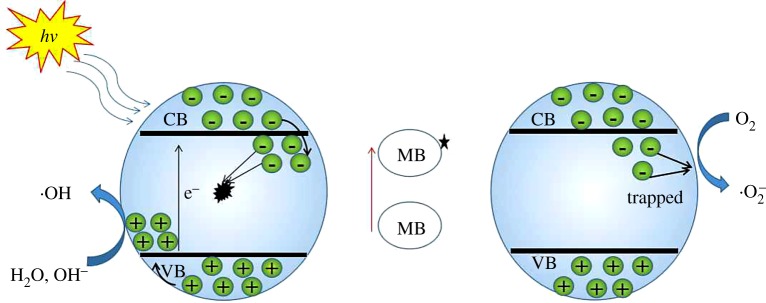
The photocatalytic mechanism of MB degraded by Tb–TiO2 under UV light irradiation.